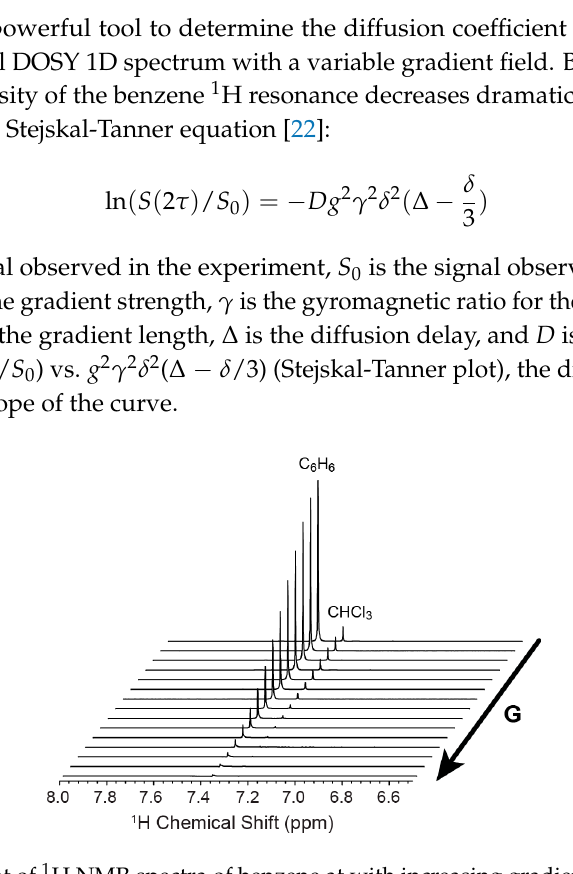
Figure 3. Stack plot of 1 H NMR spectra of benzene at with increasing gradient field strength (G).